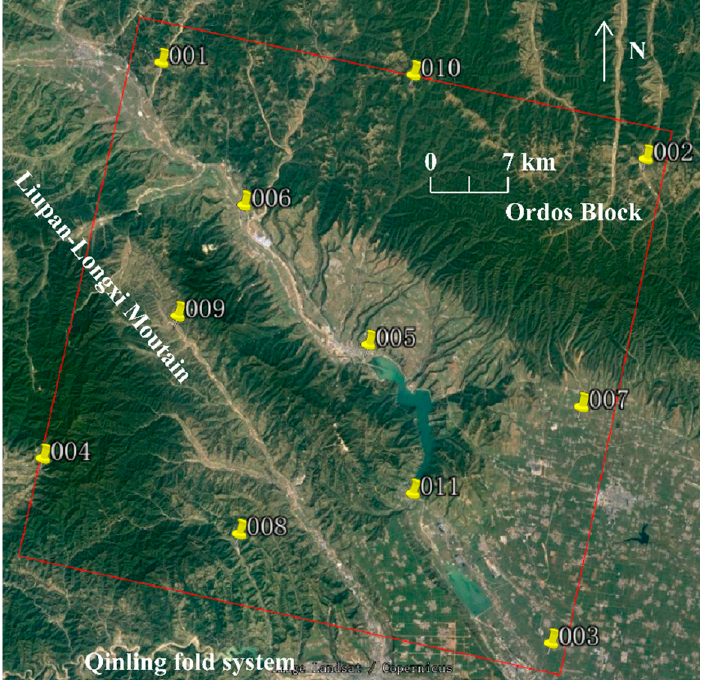
Figure 3. Representative distribution of ground control points (GCPs) in a single ZY3 scene region in the Qianhe Basin. The red line is the area of the ZY3 stereo images and the yellow points are the